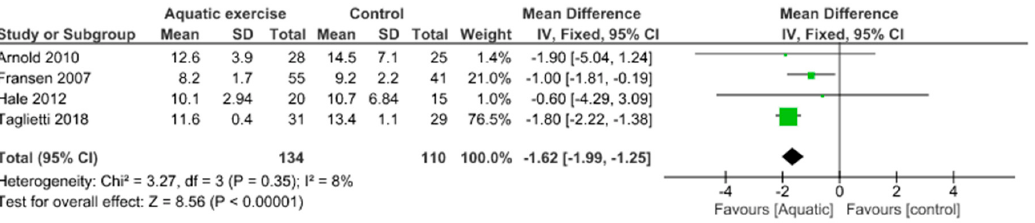
Figure 19. Dynamic Balance: Aquatic exercise versus Control.